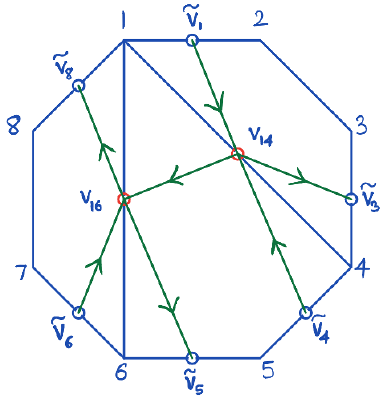
Figure 5 . f 14,16 g quadrangulation of an